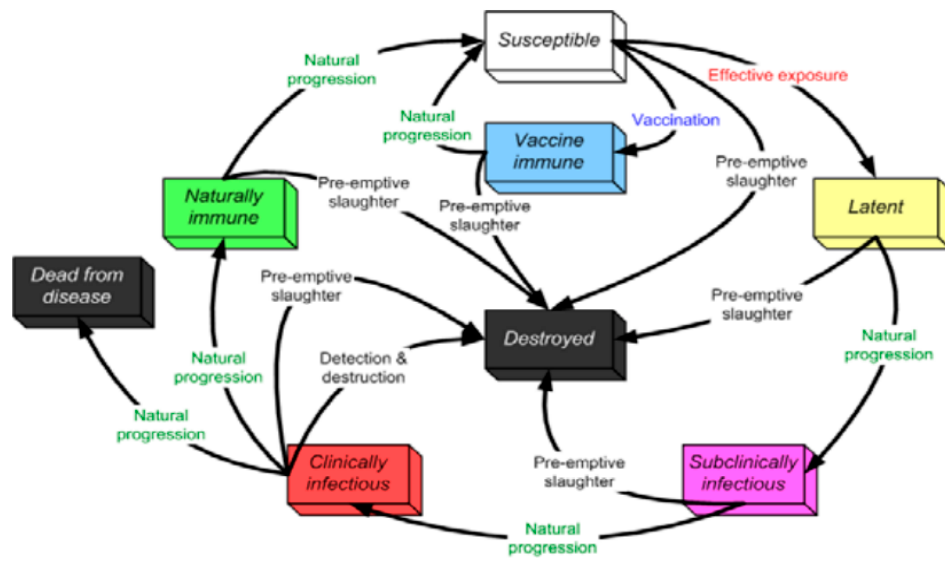
Figure 5. States and transitions simulated by NAADSM.